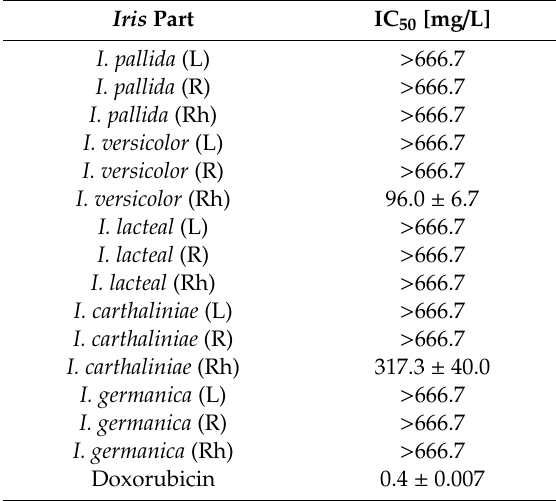
Table 4. Concentration of Iris spp. extract halving viability of fibroblasts (MRC) cell